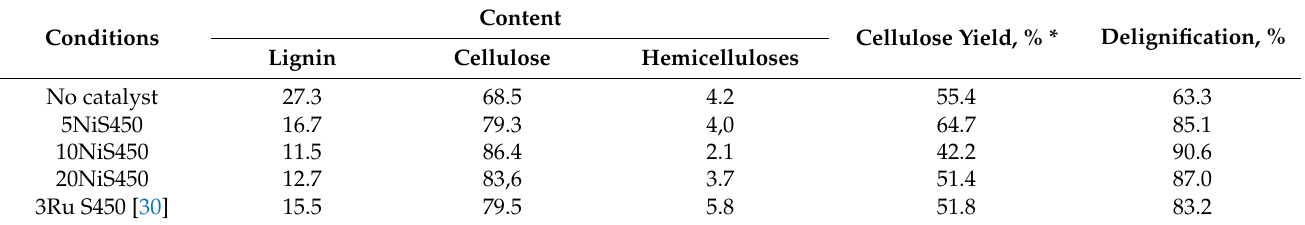
Table 4. Effect of the metal content in the catalyst on the composition of solid products from the fractionation of flax shives (225 ° С , 3